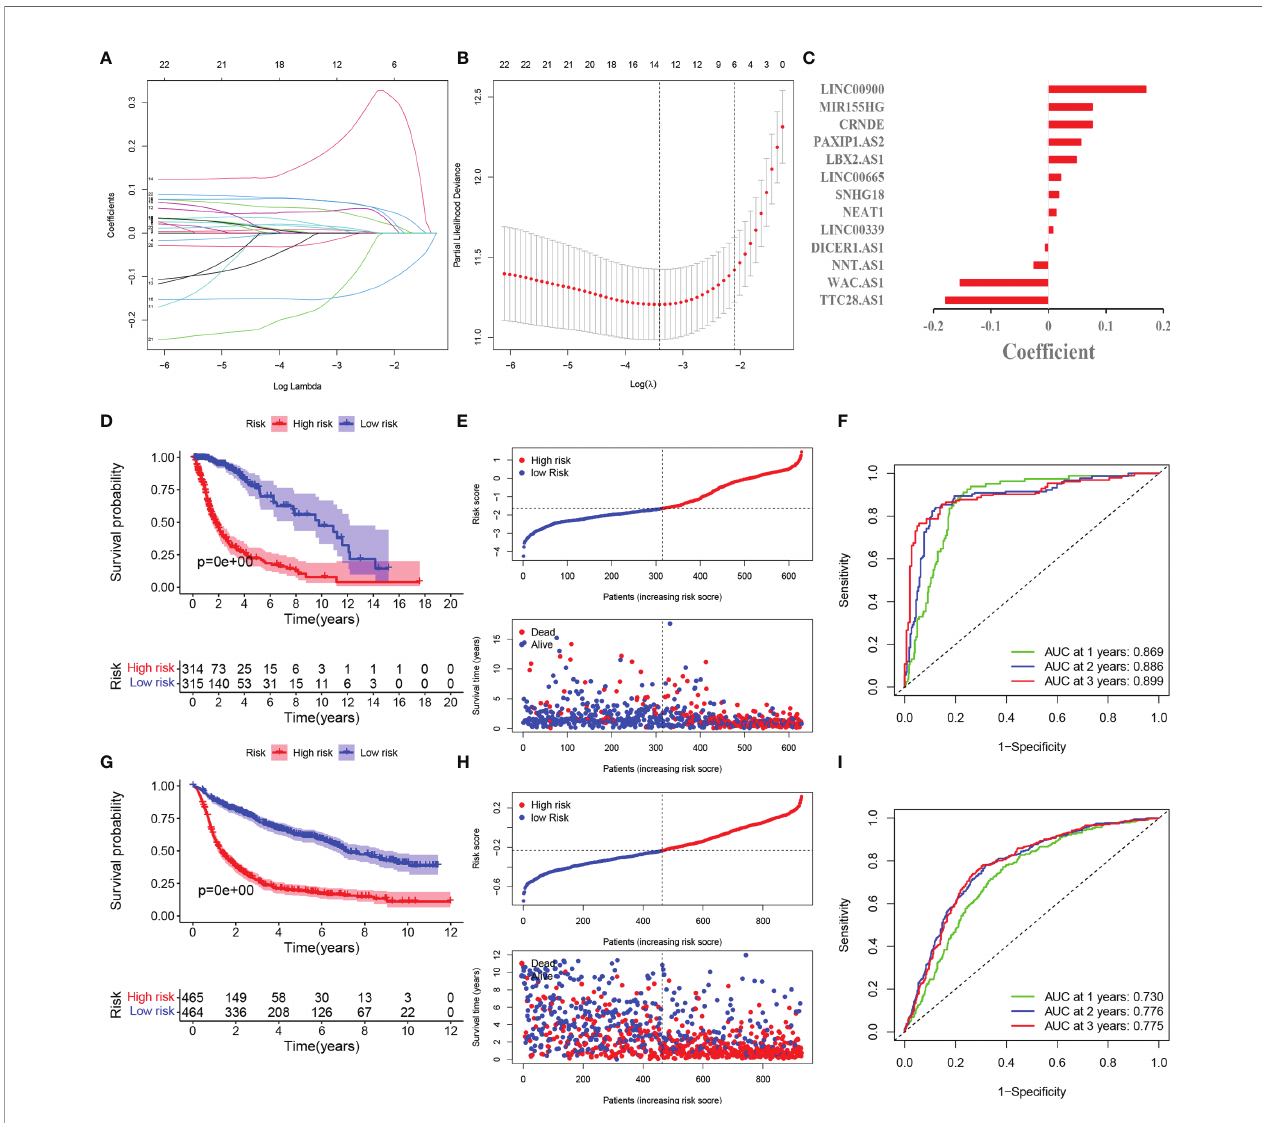
FIGURE 2 | Development and validation of pyroptosis-related lncRNAs prognosis signature. (A) LASSO regression of 13 prognosis-related genes. (B) Cross- validation for tuning the parameter selection in the LASSO regression. (C) Coef fi cient of model regression. (D) Kaplan-Meier curves of high-risk group and low-risk group in TCGA. (E) Distribution of risk score and patients based on the risk score in TCGA. (F) ROC curves of prognostic signature based on risk score. (G) Kaplan- Meier curves of high-risk group and low-risk group in CGGA. (H) Distribution of risk score and patients based on the risk score in CGGA. (I) ROC curves of prognostic signature based on risk score in